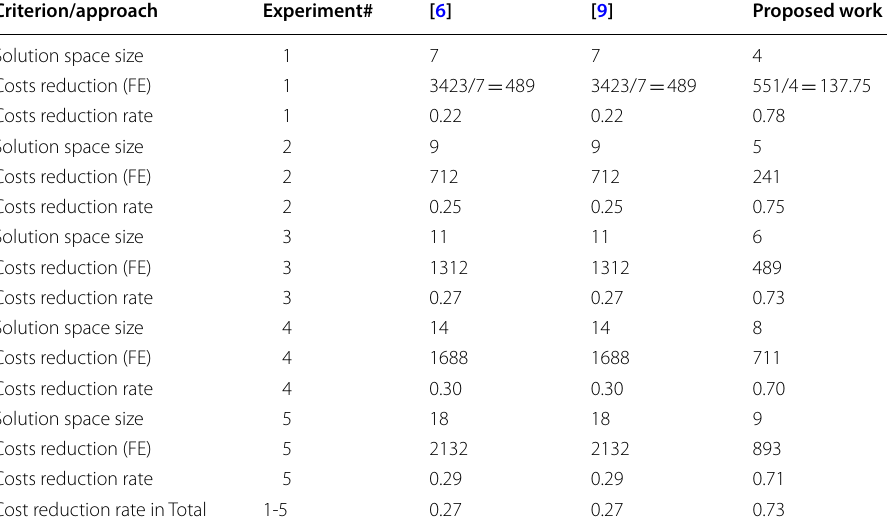
Table 24 FE values of schemes produced in (proposed work, and [6, 9]